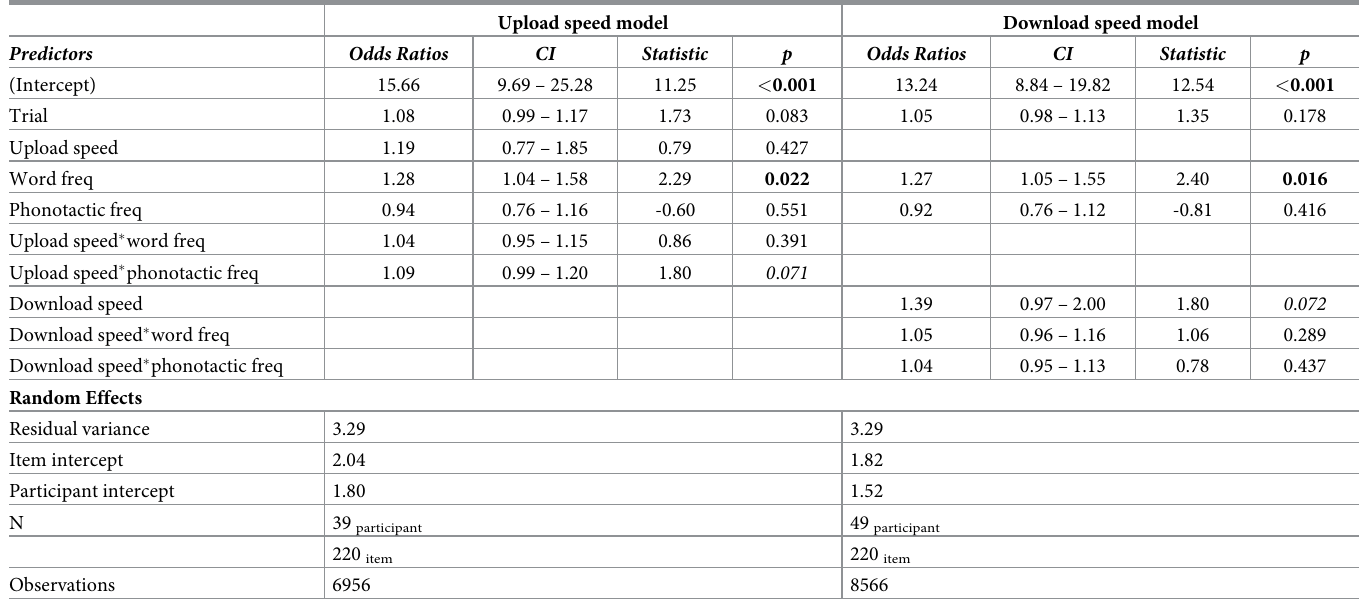
Table 7. Generalised linear mixed model output on correct versus null responses, with separate models for upload and download speed